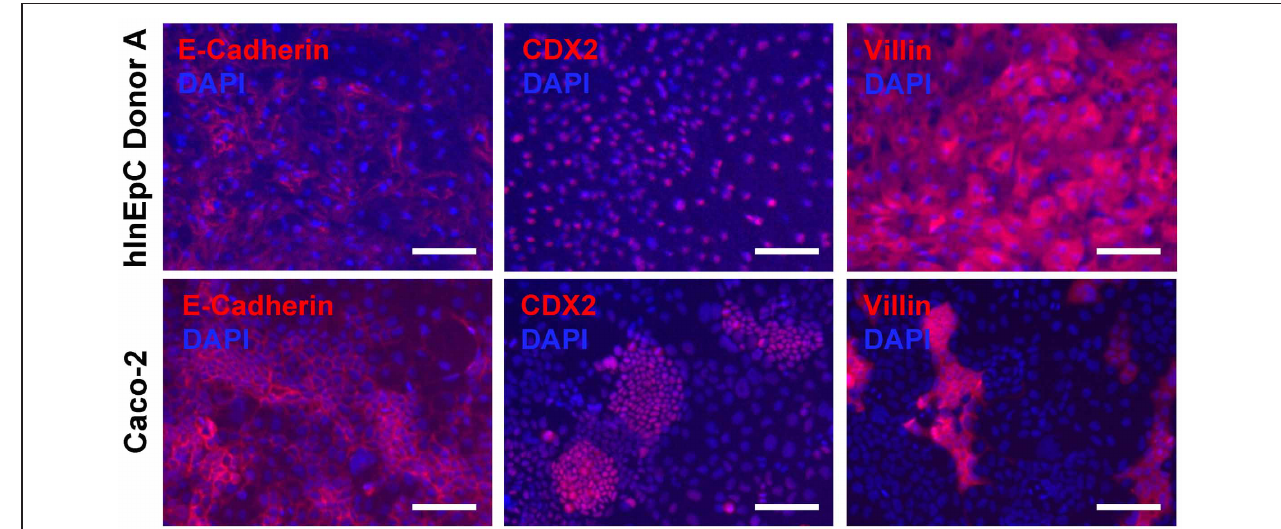
E-Cadherin (tight junctions), CDX2 (hindgut), and Villin (enterocytes). Primary hInEpC Donor A shown (see Figure A1B for Donors B and C). Bottom row : Caco-2 show less uniform expression of enterocyte marker Villin. Scale bar, 100 μ